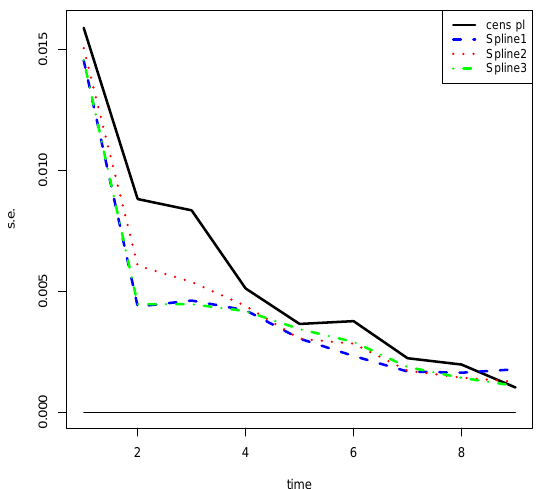
Figure 5. Standard errors for each of the three splines of “cens pl” estimators.